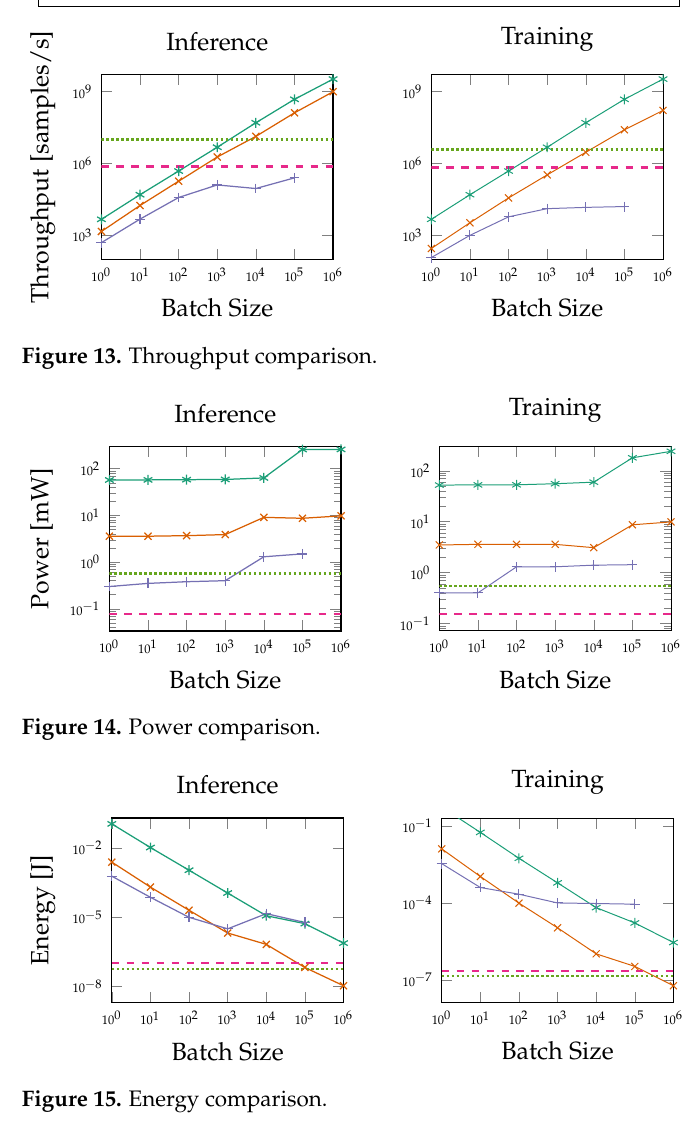
Figure 15. Energy